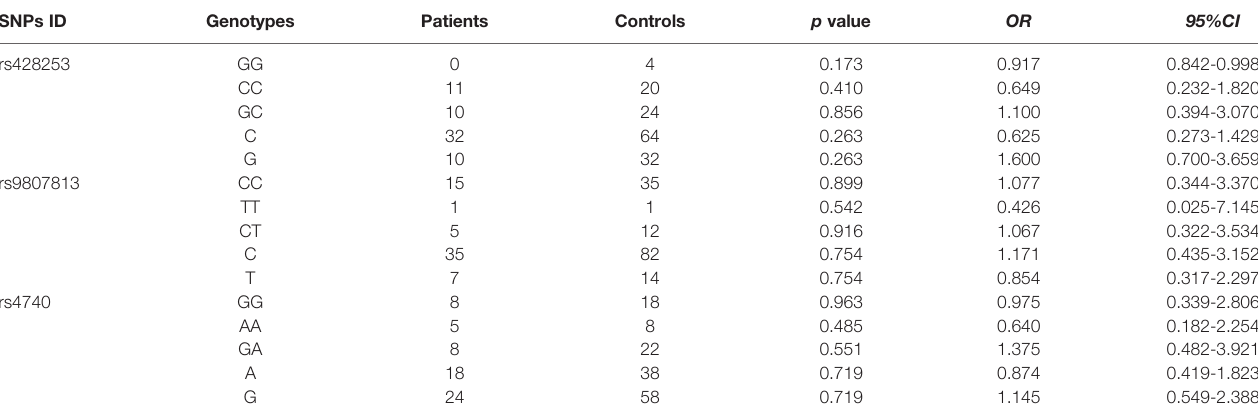
TABLE 4 | EBI3 genotypes and alleles frequencies of genotypes SNPs in VKH and healthy controls. SNPs